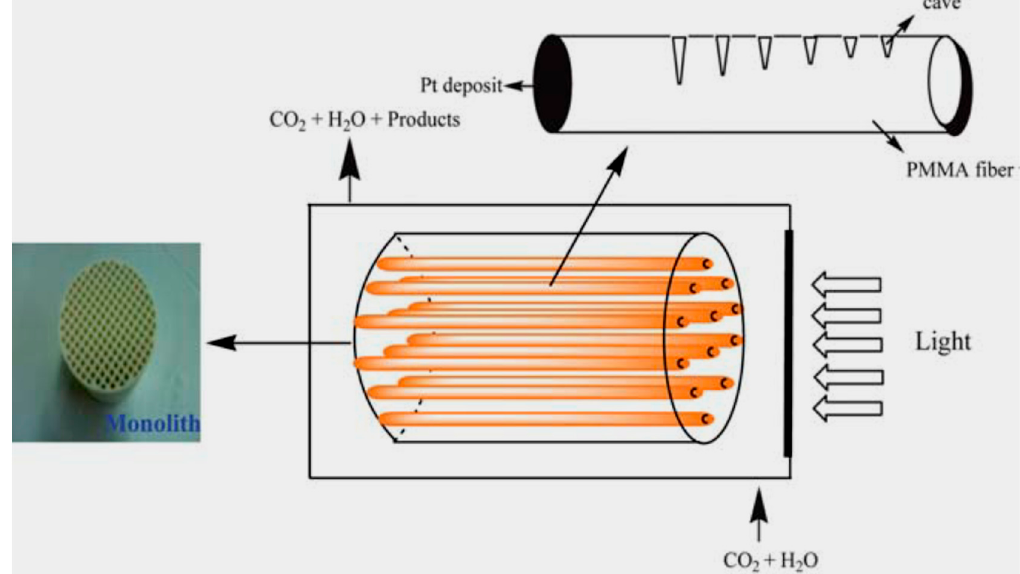
Figure 8. Illustration of monolith fiber optic reactor, reproduced from reference [35] with permission from The Royal Society of Chemistry.